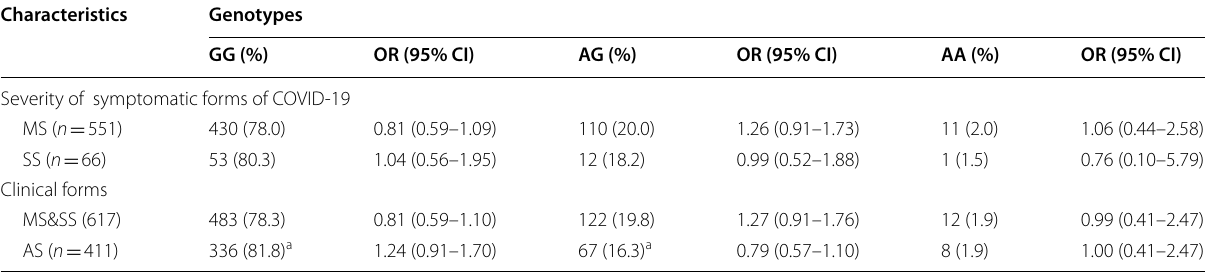
Table 3 Genotype frequencies and odds ratios in degree of severity and clinical forms of COVID‑19 according to TNFα polymorphism